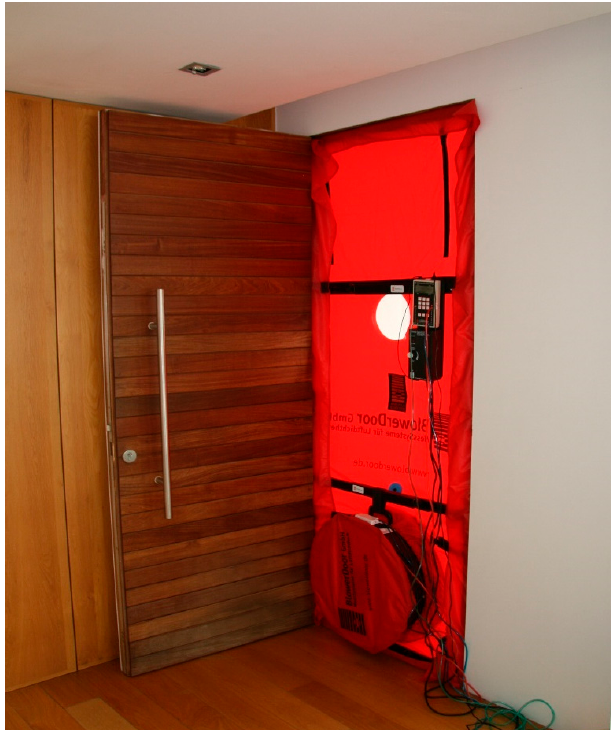
Figure 18. The model images in Design Builder. TCP panels are in yellow.